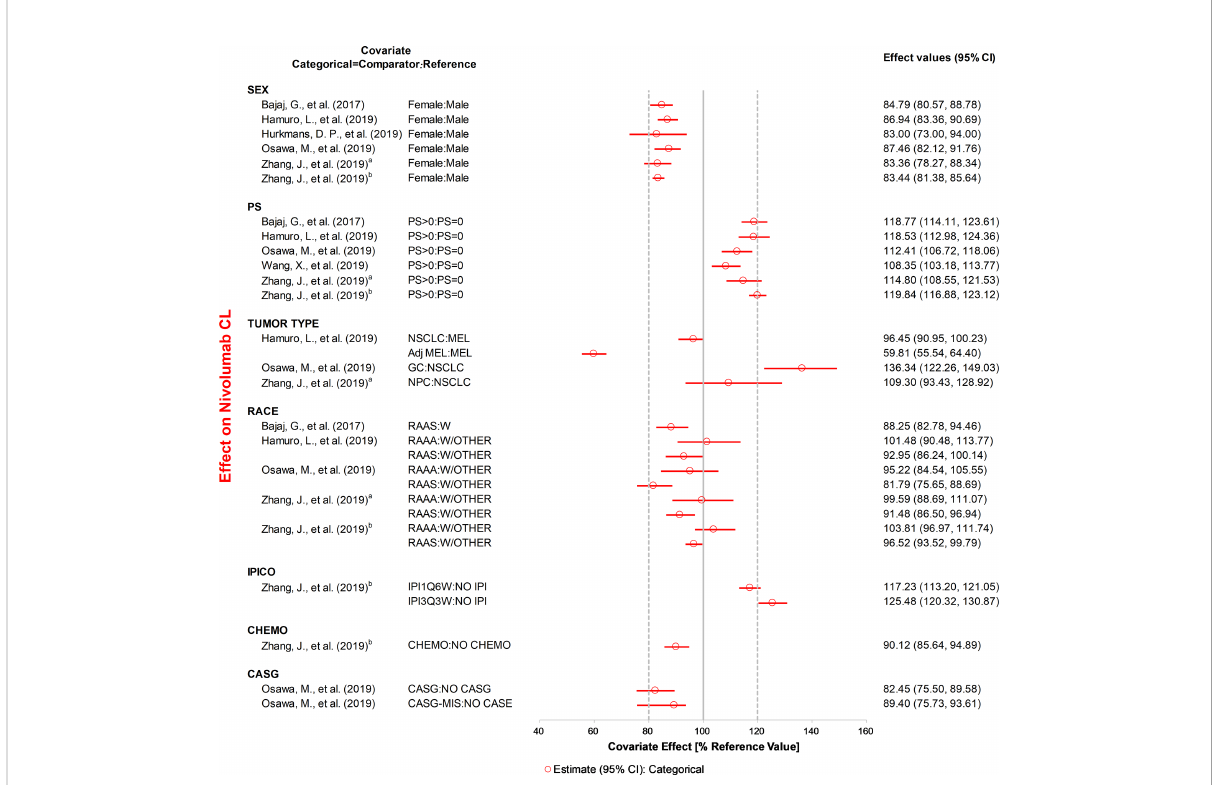
FIGURE 3 The effects of included categorical covariates on CL of nivolumab. Categorical covariate effects (95% con fi dence interval [CI]) are represented by open symbols (horizontal lines). The typical value of clearance in each study was considered to be 1. The effect of each covariate for clearance is displayed by the ratio of clearance in the range of each covariate to the typical clearance value. PS, performance status; IPICO, ipilimumab coadministration; CHEMO, chemotherapy; CASG, with prior gastrectomy. a Reference (31), b Reference